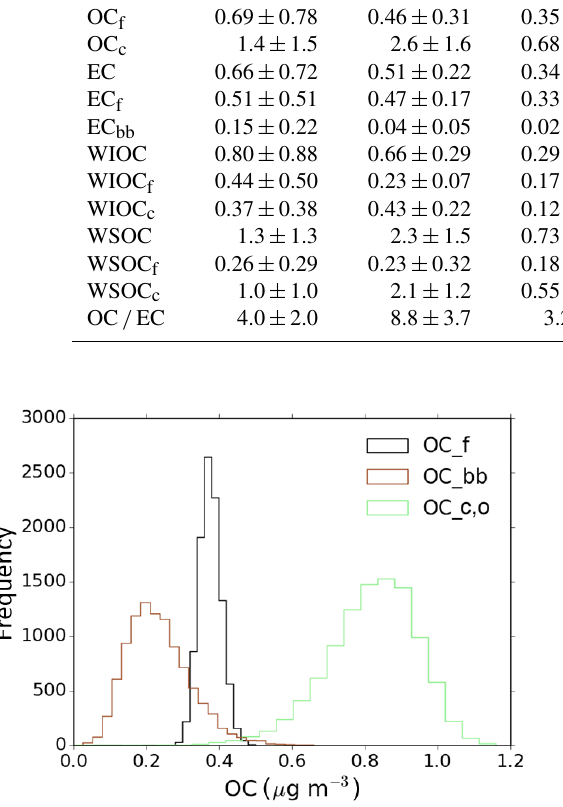
Figure 4. An example of the frequency distribution of OC con- centrations from fossil-dominated, biomass burning, and biogenic sources for sample CA36, taken in June 2011. The concentrations of OC bb and OC c , o are not independent, AND larger concentrations of OC bb correspond to smaller concentrations in OC c , o